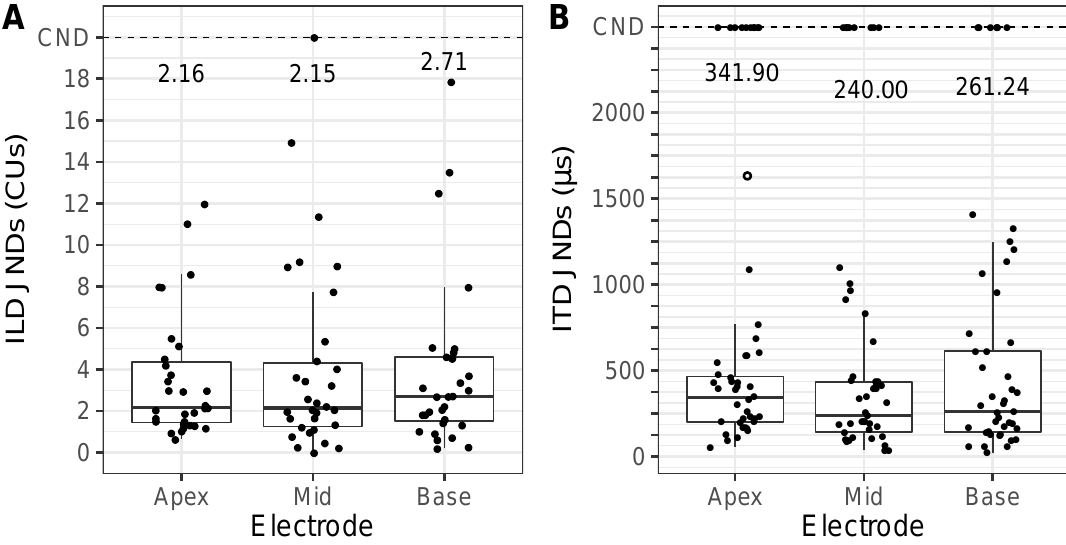
Figure 2. Box plots depicting ( A ) Interaural level di ff erence (ILD) Just-noticeable di ff erences (JNDs) for each electrode pair that was tested. Data shown have all ILD JNDs, including JNDs that could not be determined. Medians represent the data with only JNDs below 20 CUs. Black dashed line indicates the “could not determine” (CND) mark for JNDs > 20 CU. ( B ) Box plots depicting ITD JNDs for each electrode pair that was tested. Data shown have all ITD JNDs, including JNDs that could not be determined. Medians represent the data with only measurable thresholds. Black dashed line indicates the CND mark for JNDs. Subject IBX who was tested with 2000 µ s had a JND that exceeded 1600 µ s, and therefore the open-circle symbol represents subject